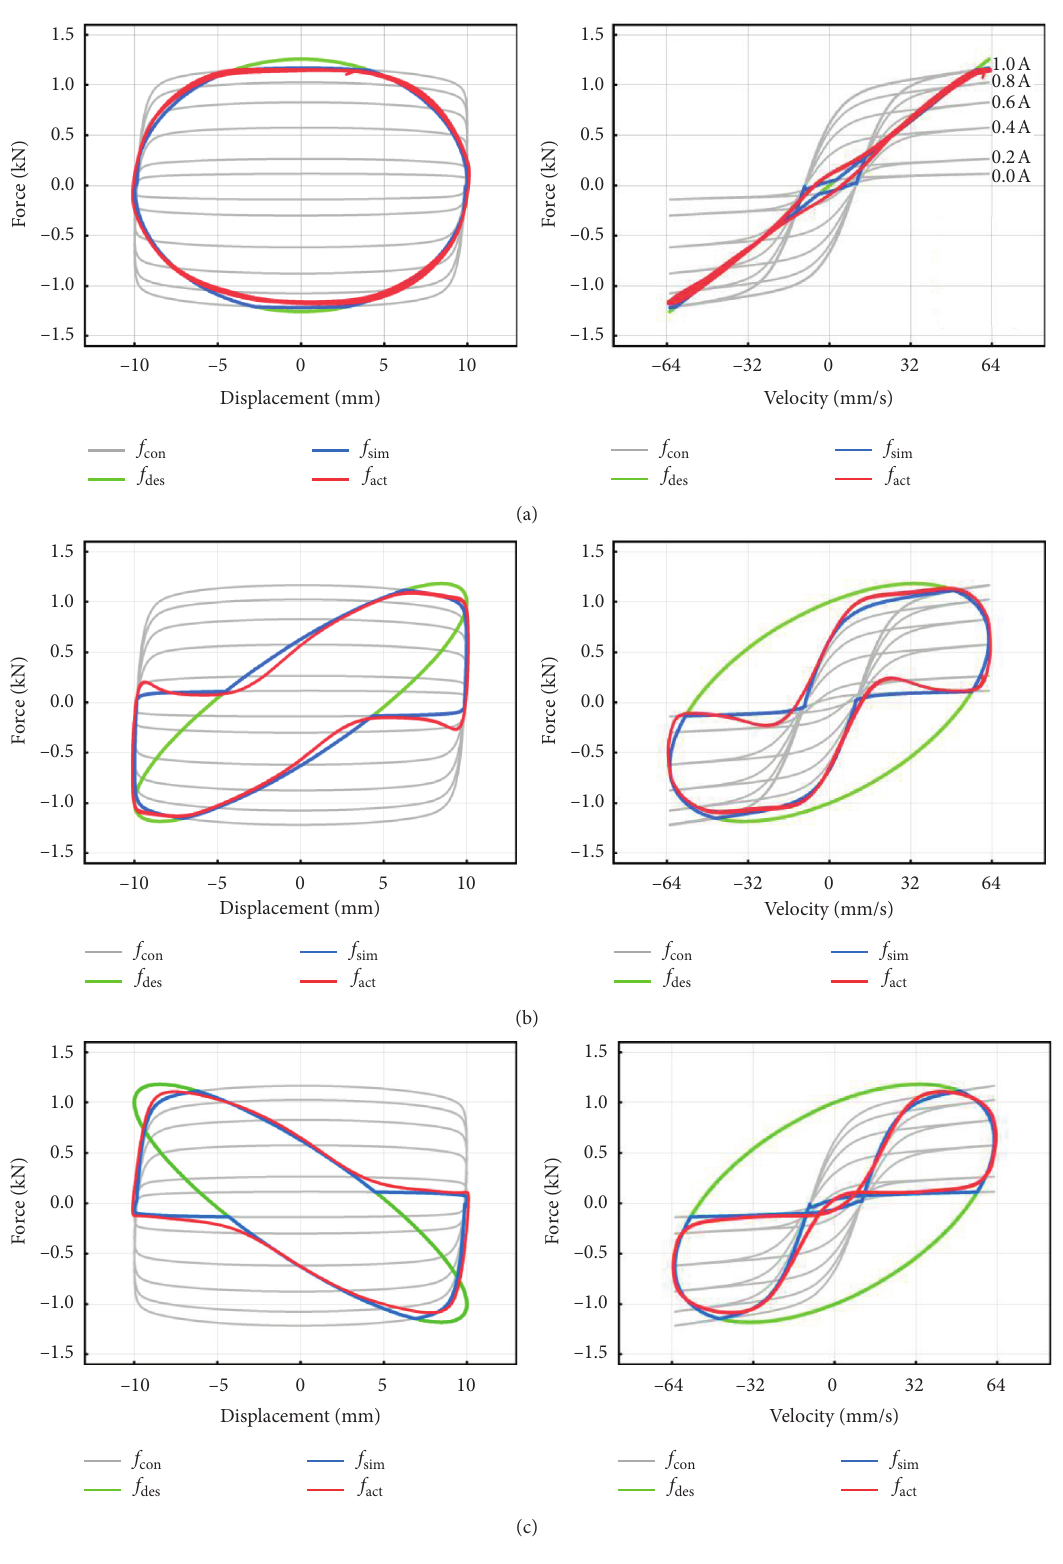
8: Partial results of force tracking scheme. (a) Viscous case ( c � 10N/m · s , k � 100N/m). (c) Negative stiffness ( c ( c des des